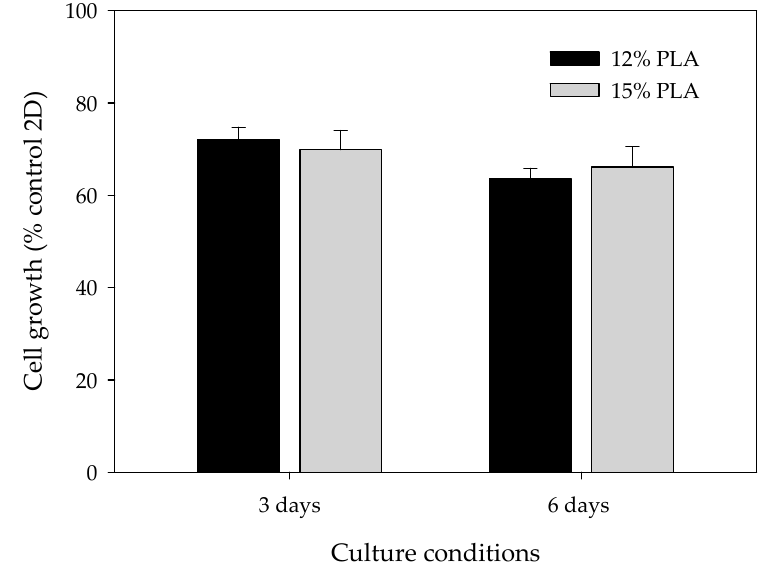
Figure 4. Cell proliferation analysis for MDA-MB-231 cells cultured in 3D using 12% PLA scaffolds (black bars) or 15% PLA scaffolds (grey bars) over three days (left) or six days (right). MDA-MB-231 cells cultured in 2D were used as a control. Experiments were performed at least three times.